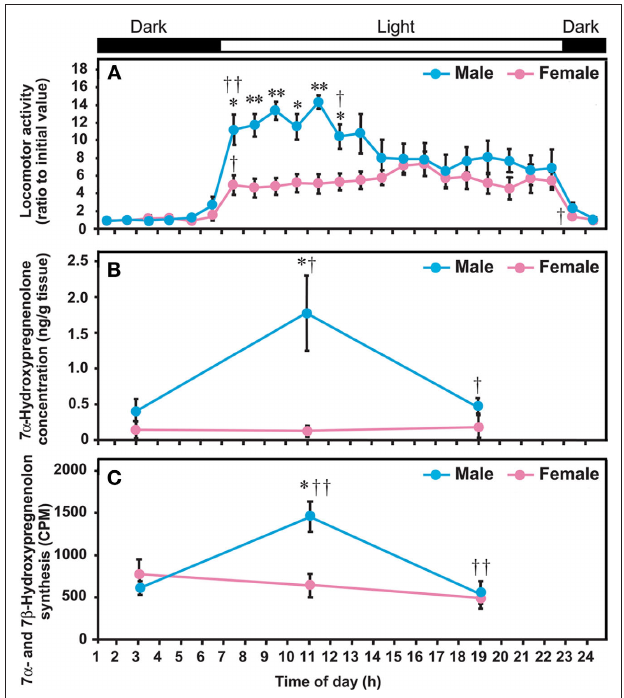
FigurE 5 | Diurnal changes in locomotor activity of quail, and 7 α -hydroxypregnenolone concentration and 7 α - and 7 β -hydroxypregnenolone synthesis in the quail diencephalon. Quail were housed under LD photoperiods (lights on at 07:00 am). (A) Locomotor activity. (B) 7 α -Hydroxypregnenolone concentration in the diencephalon. (C) 7 α - and 7 β -Hydroxypregnenolone synthesis in the diencephalon. Locomotor activities of males and females are expressed as the ratio to the initial value observed during 01:00–02:00 am in each sex. Values represent the mean ± SEM ( n = 5) for each time. ** p < 0.01 and * p < 0.05 vs. female; †† p < 0.01 and † p < 0.05 vs. previous time by one-way ANOVA, followed by Duncan’s multiple range test. Adapted from Tsutsui et al.